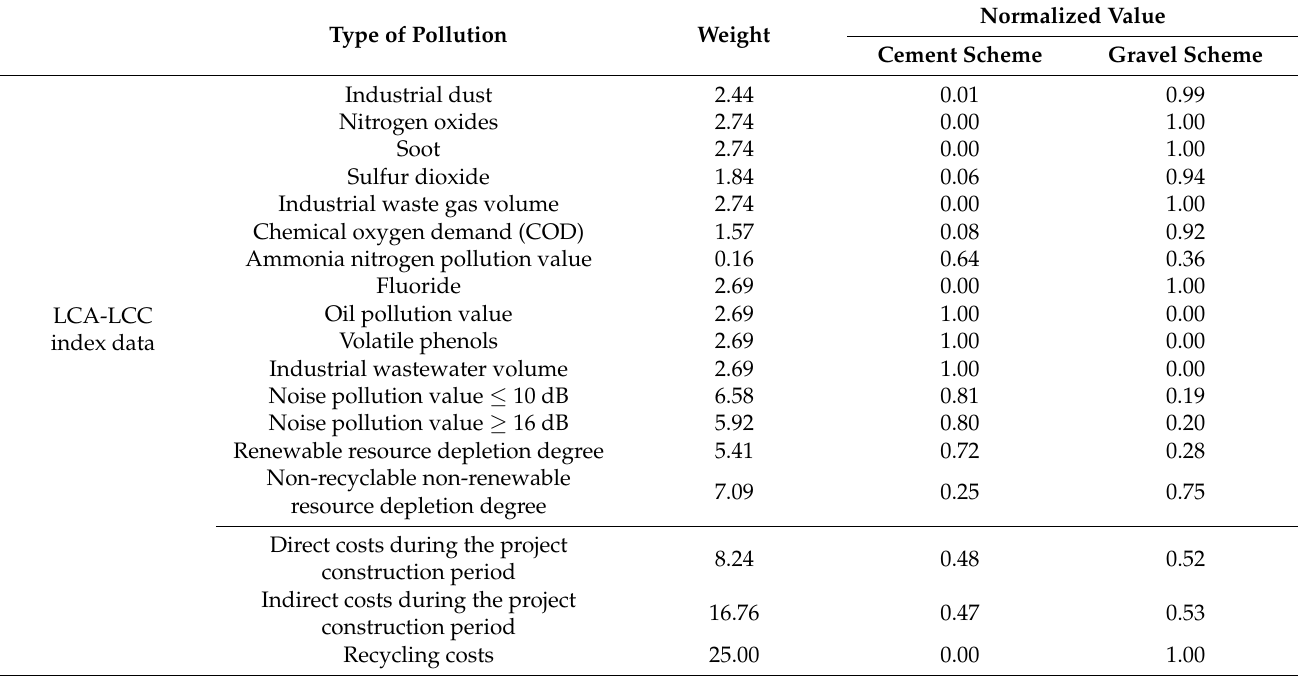
Table 6. LCA-LCC data and index weights.